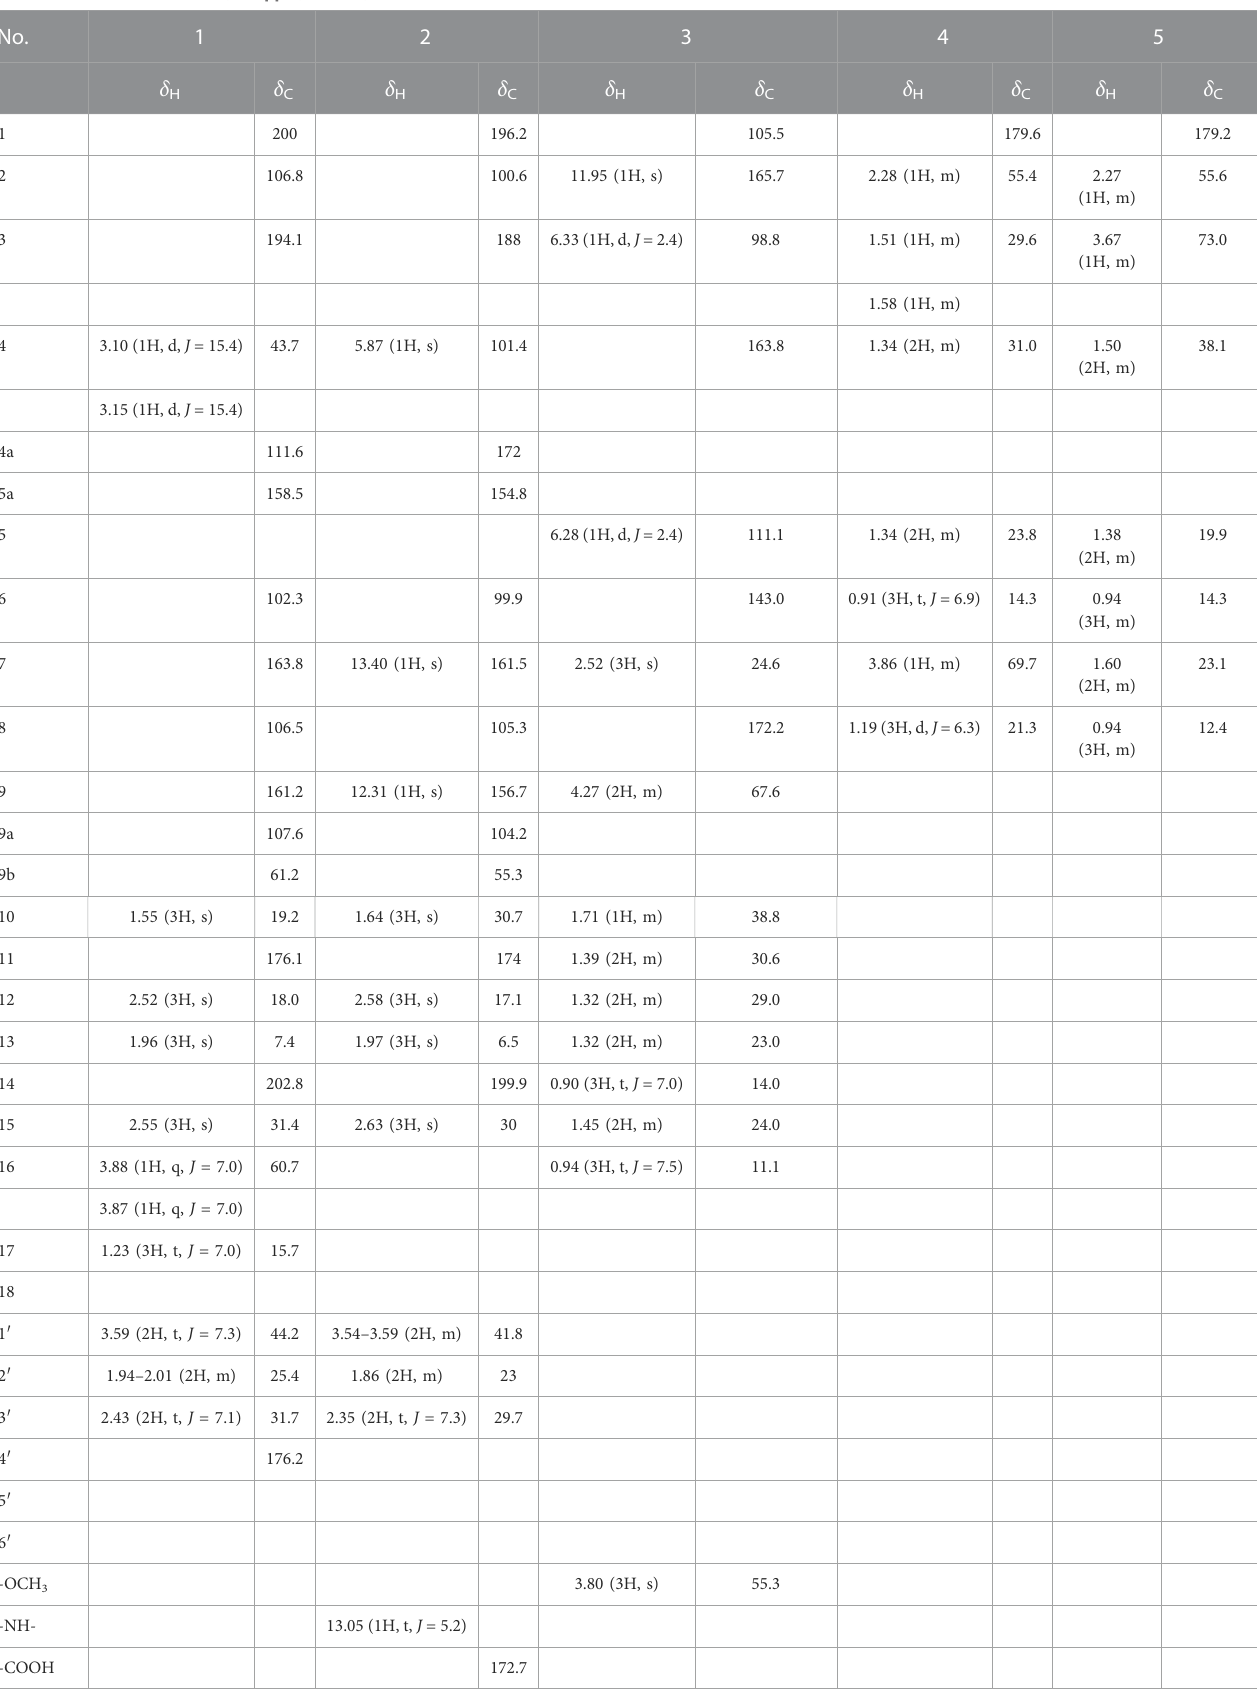
TABLE 1 1 H and 13 C NMR data ( δ in ppm, J in Hz) for 1 – 5 .